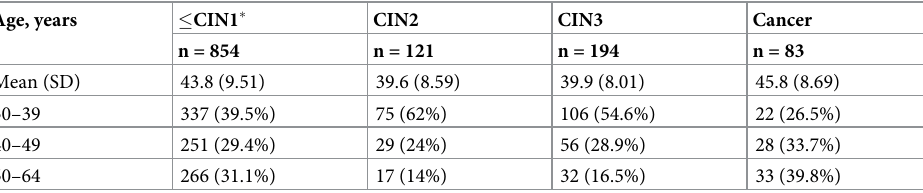
Table 1. Distribution of age in by histological group in HPV screened positive women.